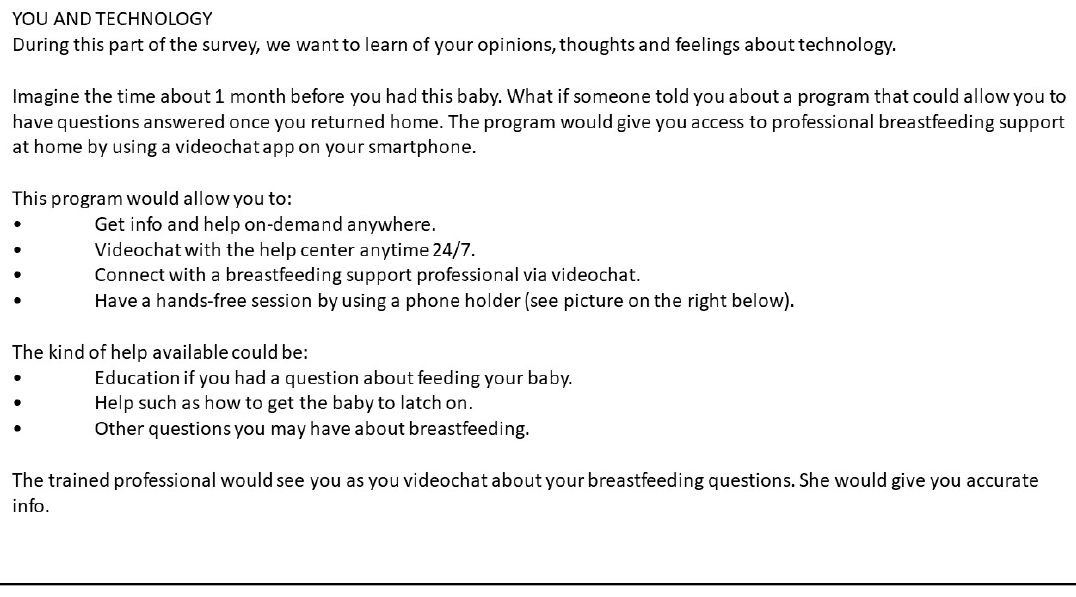
Figure 1. Brief synopsis of breastfeeding support application provided to participants. Table 1. Willingness to use telelactation survey questions.